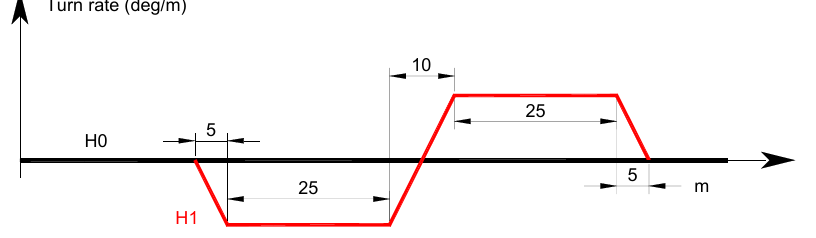
Figure 2. Simplified turn rate signals for main track in black (H0) and siding track in red (H1).